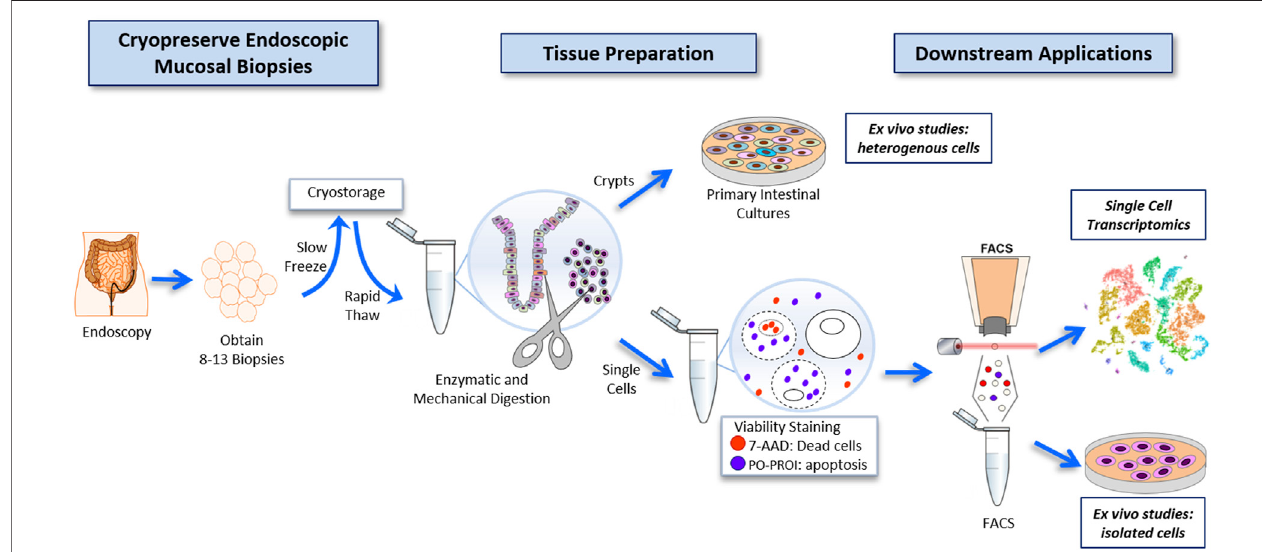
FIGURE 1 | Work fl ow for the cryopreservation of endoscopically obtained human intestinal mucosal biopsies, and subsequent preparation of this tissue to highly viable FACS-isolated single-cell suspensions compatible with deep single-cell RNA sequencing, and primary intestinal culture.